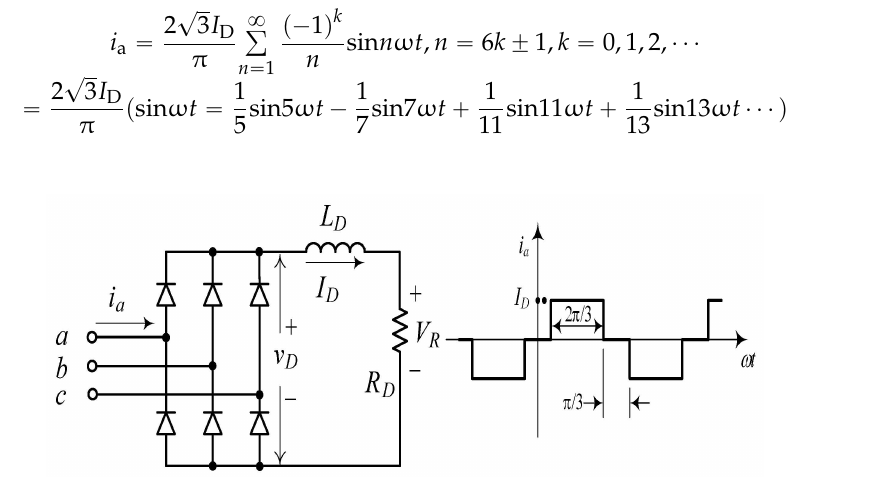
Figure 6. Generator terminal harmonic current